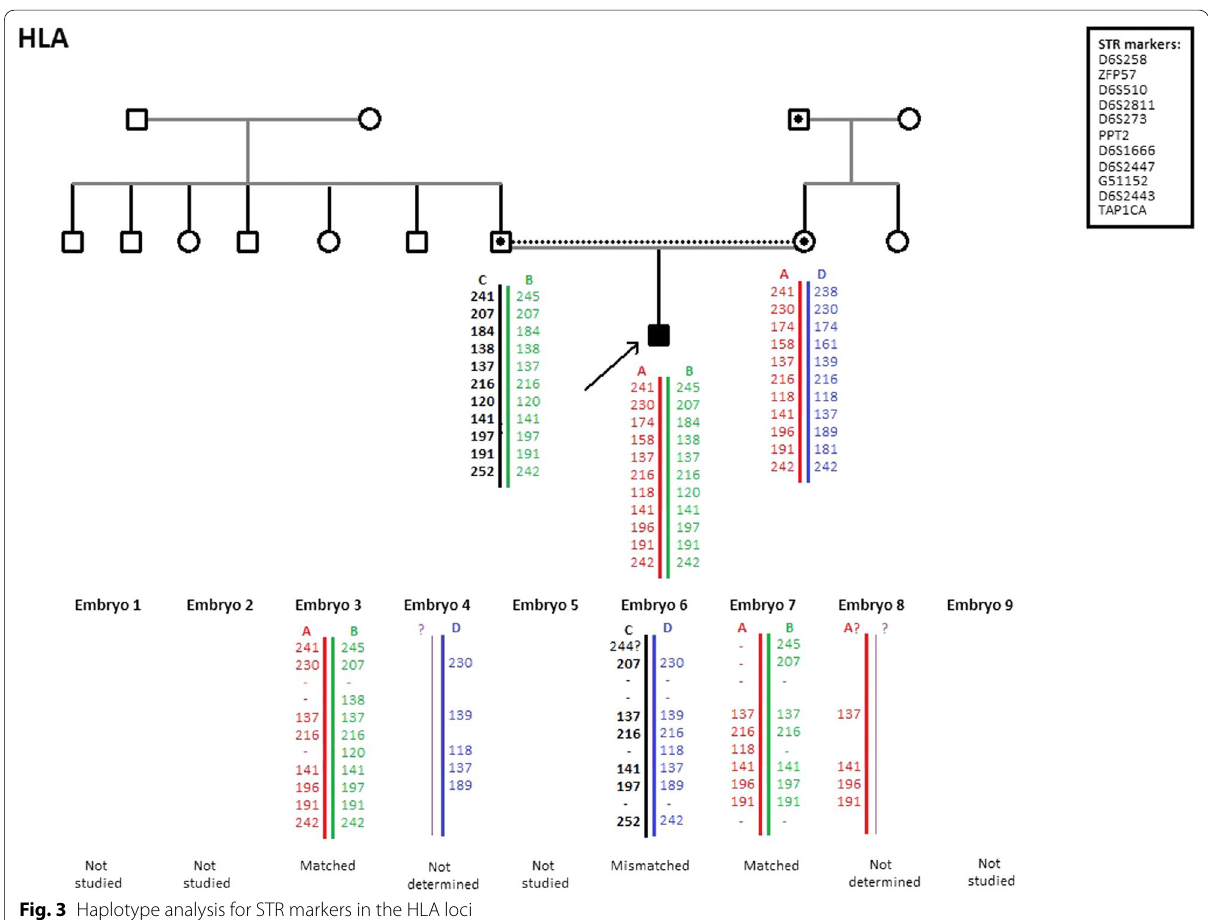
Fig. 3 Haplotype analysis for STR markers in the HLA loci